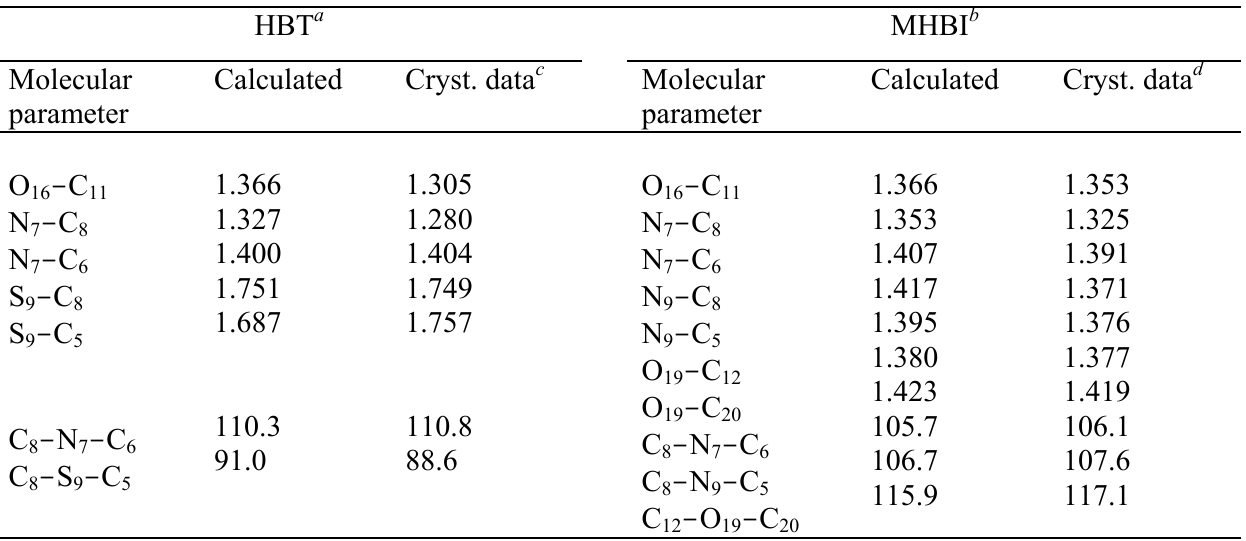
Table 1. Comparison of the calculated ground state optimized geometric parameters of HBT and MHBI with the crystallographic data [bond length ( Å ) and angles ( º